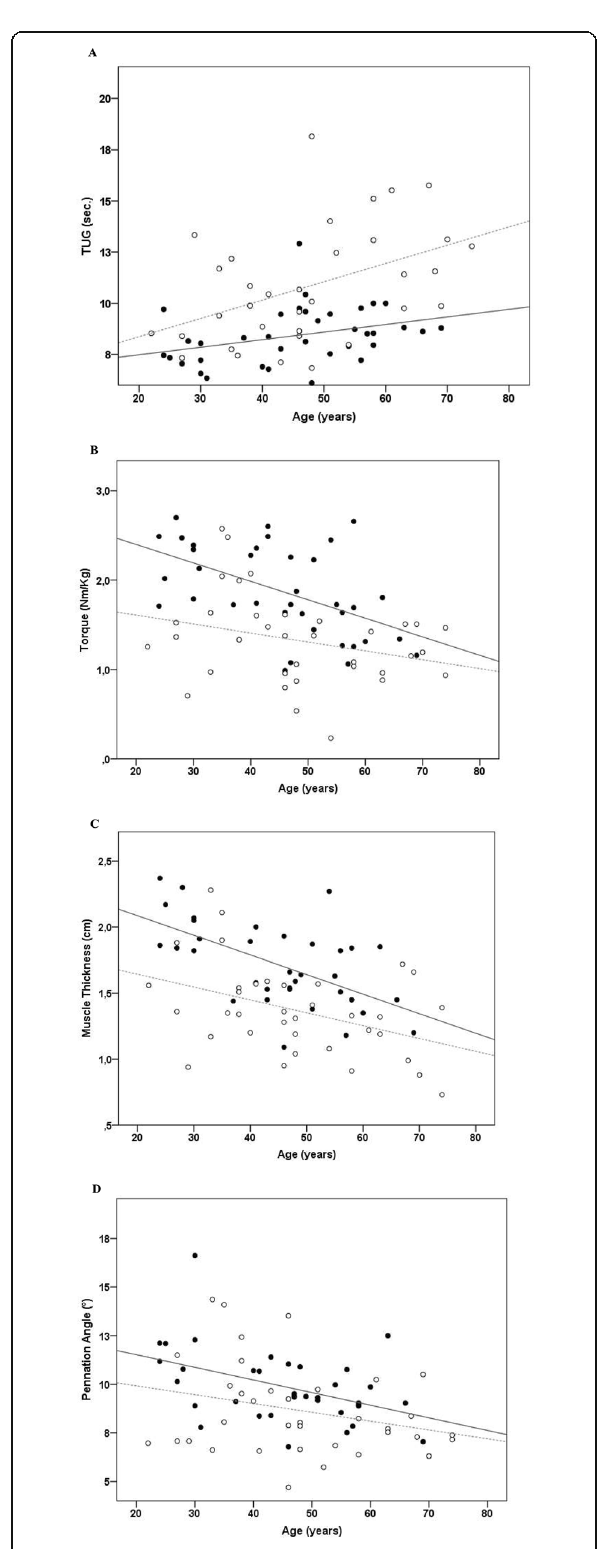
Fig. 2 Partial correlation analysis (controlling by physical activity levels) was significant between TUG and Age in both RA ( r = 0.438; p = 0.010) and CG ( r = 0.336; p = 0.048) a , Torque and Age in the CG ( r = − 0.498; p = 0.002), but not in RA ( r = − 0.317; p = 0.089) ( b ), Muscle Thickness and Age in the CG ( r = − 0.576; p < 0.001), but not in RA ( r = − 0.310; p = 0.092) ( c ) and Pennation Angle and Age in the CG ( r = − 0.462; p = 0.005), but not in RA ( r = − 0.260; p = 0.137) ( d ). Black dots = CG; White dots = RA. Solid line = CG; Dashed line =